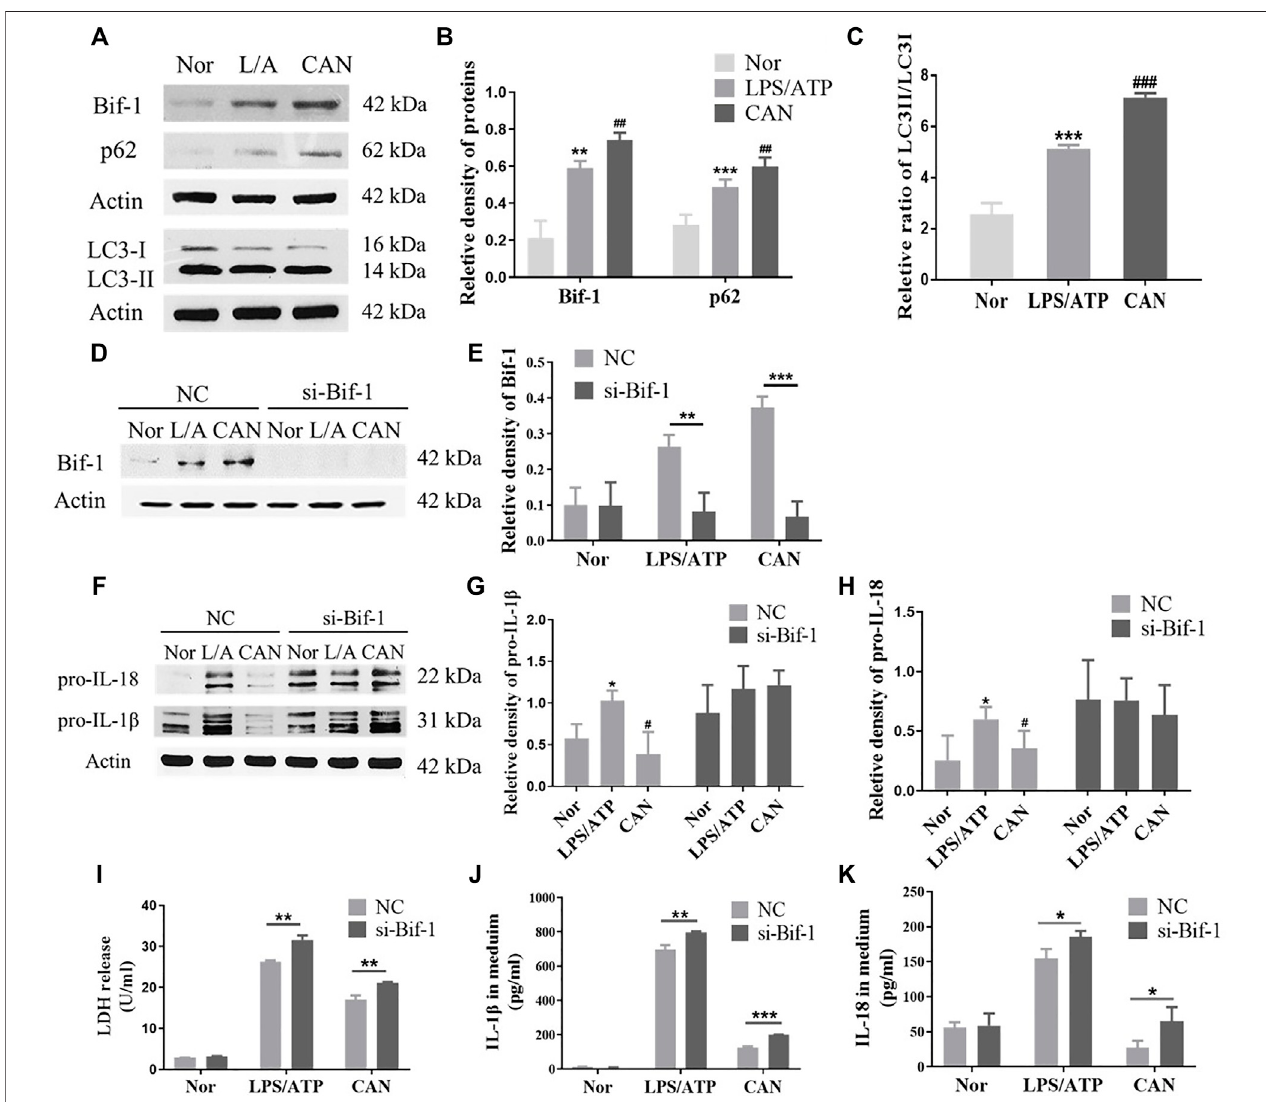
FIGURE 3 | Canagli fl ozin inhibits NLRP3 in fl ammasome activation through up-regulating Bif-1. (A – C) Effects of CAN on Bif-1, p62 and the ratio of LC3-II/LC3-I. J774A.1 cells were transfected with Bif-1 siRNA or negative control siRNA using Lipofectamine 3000. Twenty-four hours after transfection, cells were primed with LPS (500 ng/ml) for 6 h in the presence or absence of CAN (10 μ M), then stimulated with 5 mM ATP for 30 min. Whole cell lysis and supernatant were collected. Western blotting analysis of (D,E) Bif-1, (F – H) pro-IL-1 β and pro-IL-18 were presented. (I) LDH release in supernatant was assessed. (J,K) ELISA of IL-1 β and IL-18 in supernatant. Nor, normal control group; LPS/ATP (L/A), untreated LPS/ATP control group; CAN, CAN-treated LPS/ATP group. NC, negative control group; si-Bif-1, group treated with siRNA of Bif-1. Data were expressed as mean ± SD ( n = 3). Differences with a probability value of < 0.05 were considered signi fi cant. (B,C,G,H) * p < 0.05, ** p < 0.01, *** p < 0.001 vs Nor; # p < 0.05, ## p < 0.01, ### p < 0.001 vs L/A. (E) and (I – K) * p < 0.05, ** p < 0.01, *** p <